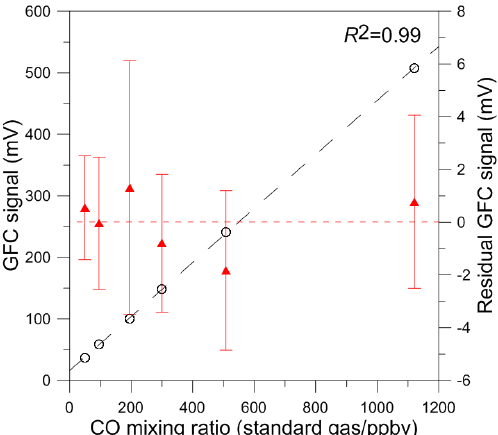
Figure 4. Linear response of GFC signals versus CO mixing ratios in the NIES 09 CO scale (open circles) determined by VURF. Averages of the GFC signal residual from the fitting line at each CO mixing ratio are also plotted (triangles) with 1 σ values as vertical bars. The residual GFC signal of 1 mV corresponds to approximately 2 ppbv.